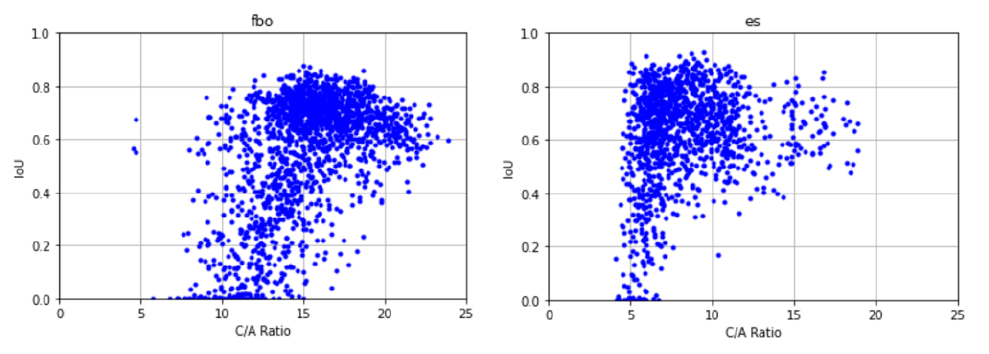
Figure 12. The scatter plots of IoU vs. the C/A ratio for the F2 and Es